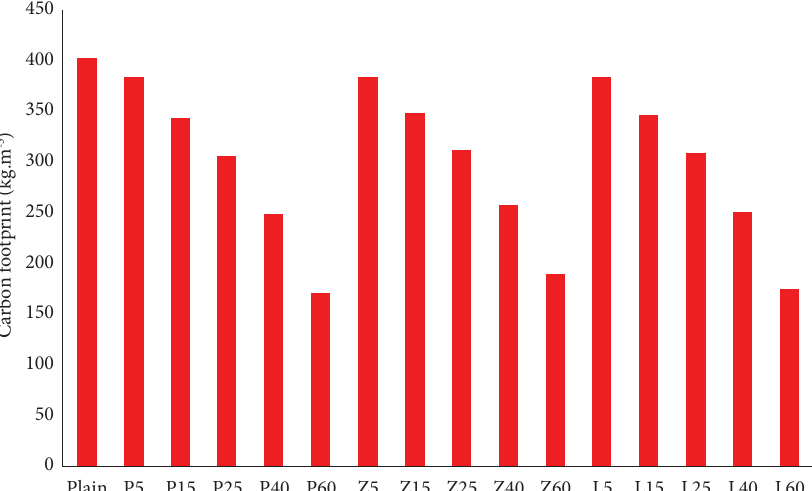
Figure 16: Te global warming index (GWI) of mixtures per cubic meter